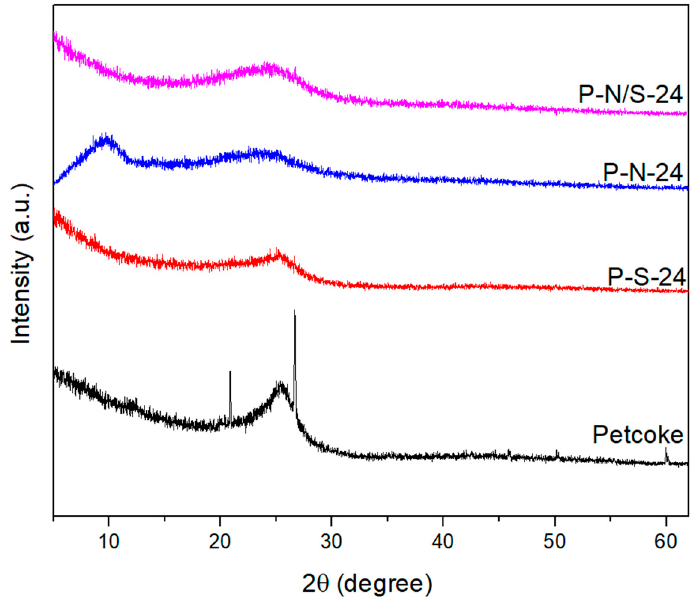
Figure 4. XRD patterns of petcoke before and after acid treatments.